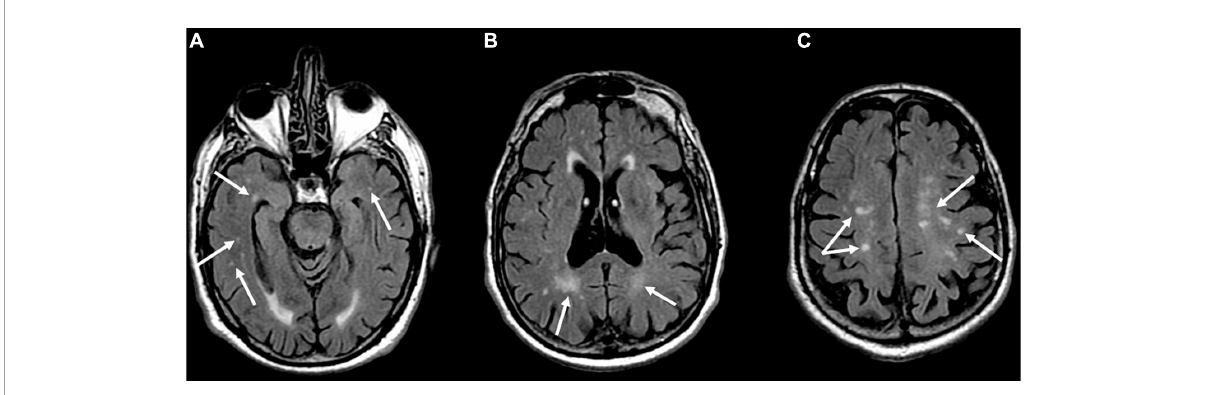
FIGURE3 Axial T2-weighted fluid-attenuated inversion recovery (FLAIR) images show multiple hyperintense signal of gliotic foci in the temporal (A) , parietal (B) , and frontal (C) white matter in a 60-year-old male patient affected by Burning Mouth Syndrome. ARWMC total score: 8; RF: 1; LF: